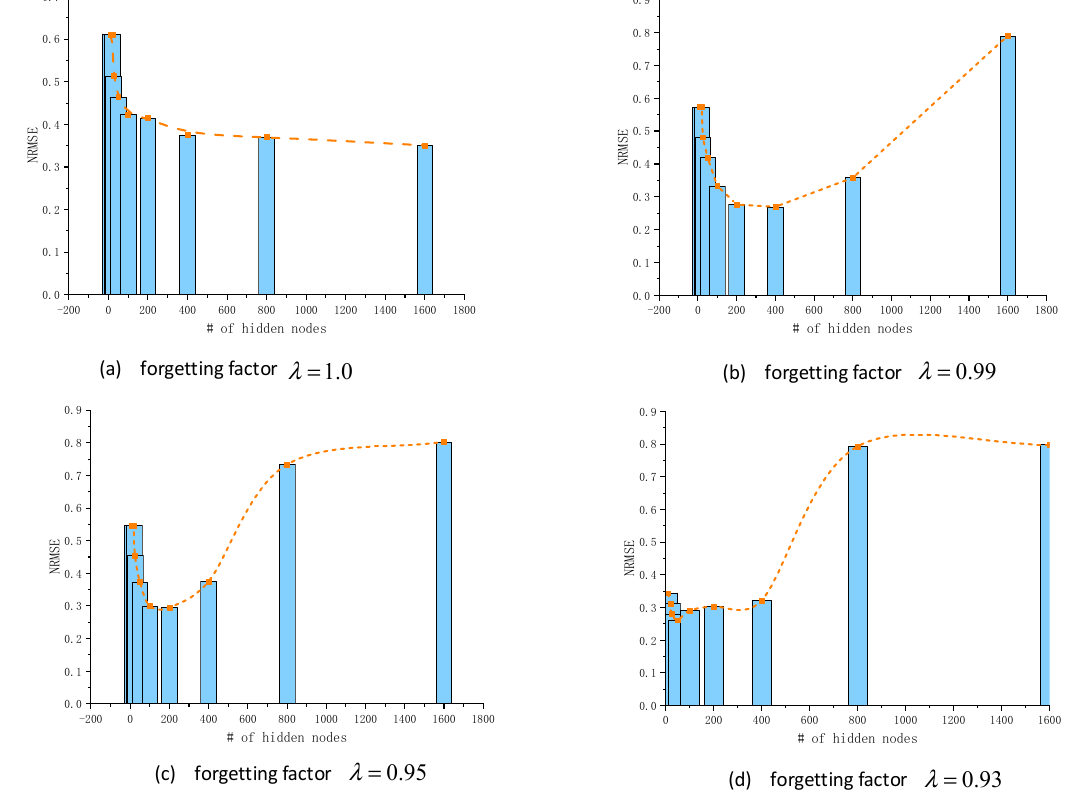
Figure 7. Performance on the prediction by Chaotic Ensemble of Online Recurrent Extreme Learning Machine (CE-ORELM). Table 1. The analysis of prediction results based on normalized root mean square error (NRMSE) and mean absolute percentage error